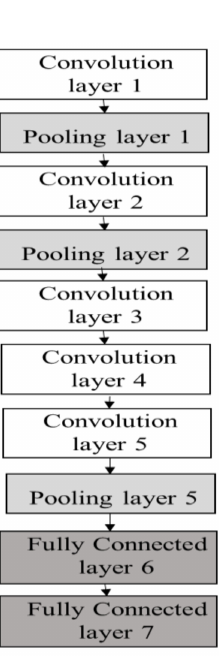
Figure 4. The architecture of AlexNet [38].